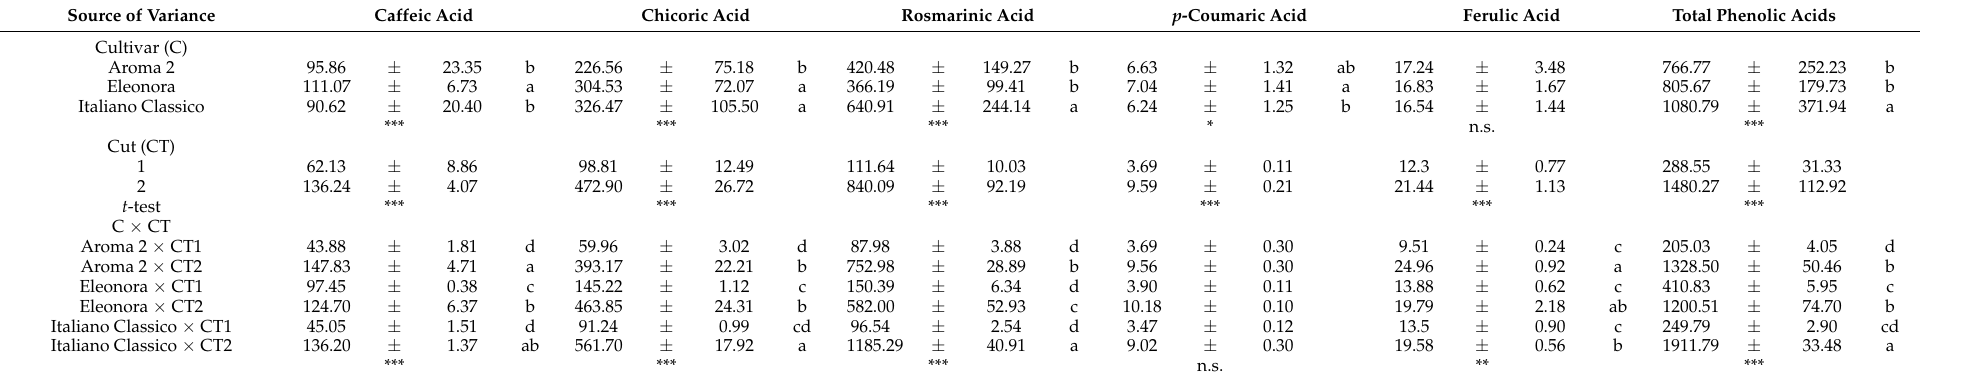
Table 2. Effect of cultivar and cut on free phenolic acids (mg kg − 1 dw) profile of basil.